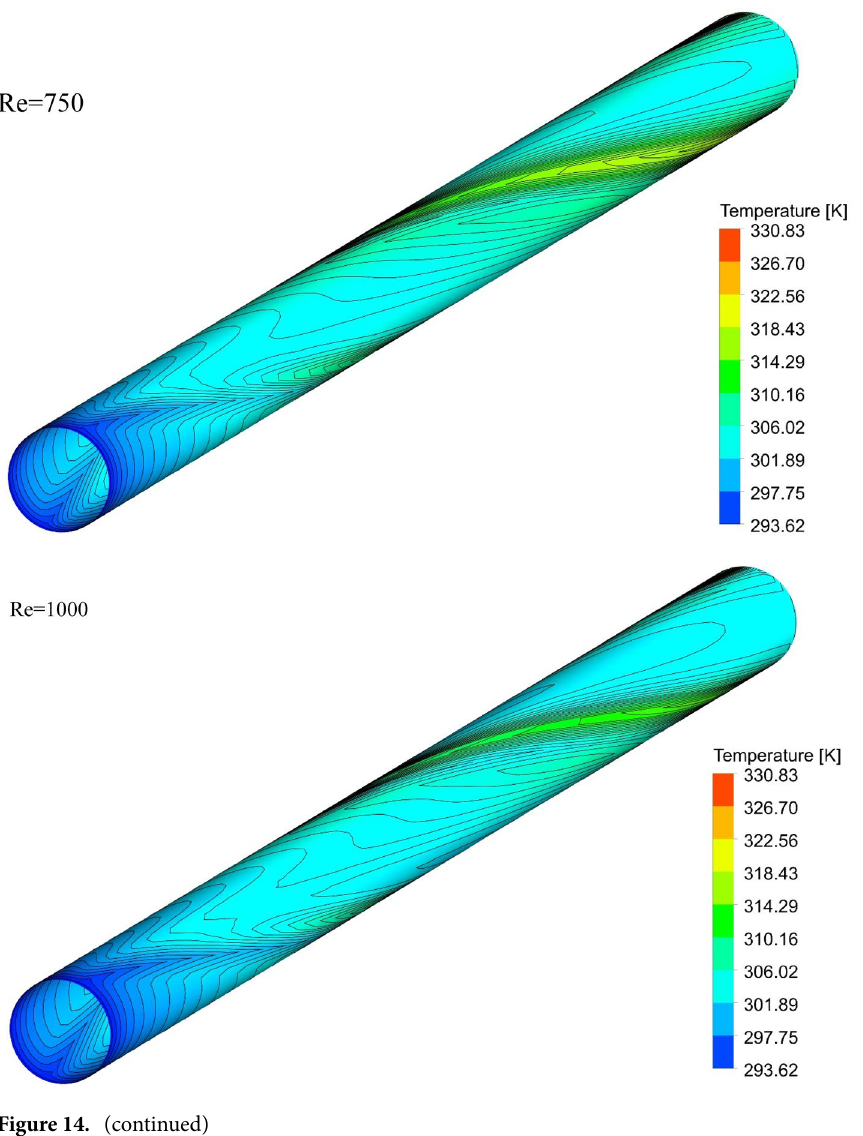
Figure 45 show the f ave versus the number